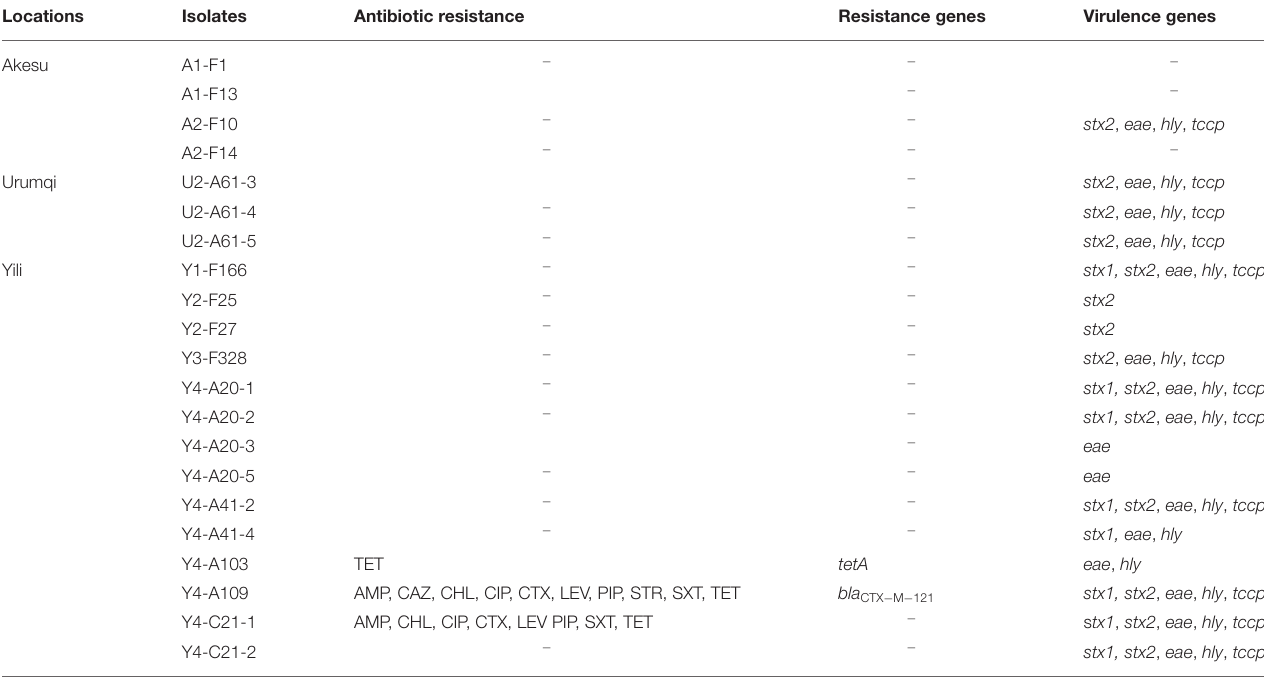
TABLE 3 | Typing antibiotic resistance and virulence genes in E. coli O157:H7 isolates.